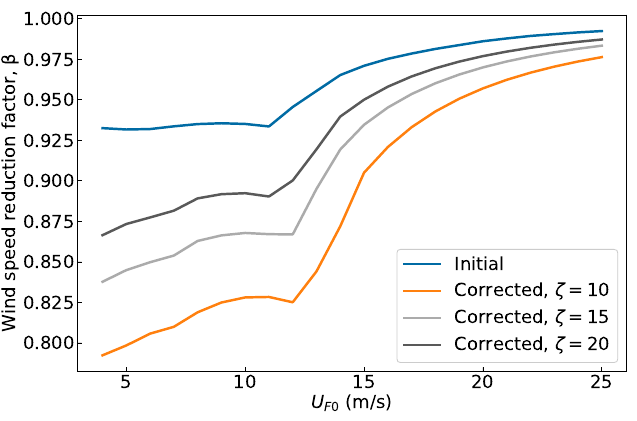
Figure 8. Comparison of the initial (Case 0) and corrected (Case A) values of β for different natural wind speeds (with a fixed wind direction of 0°).